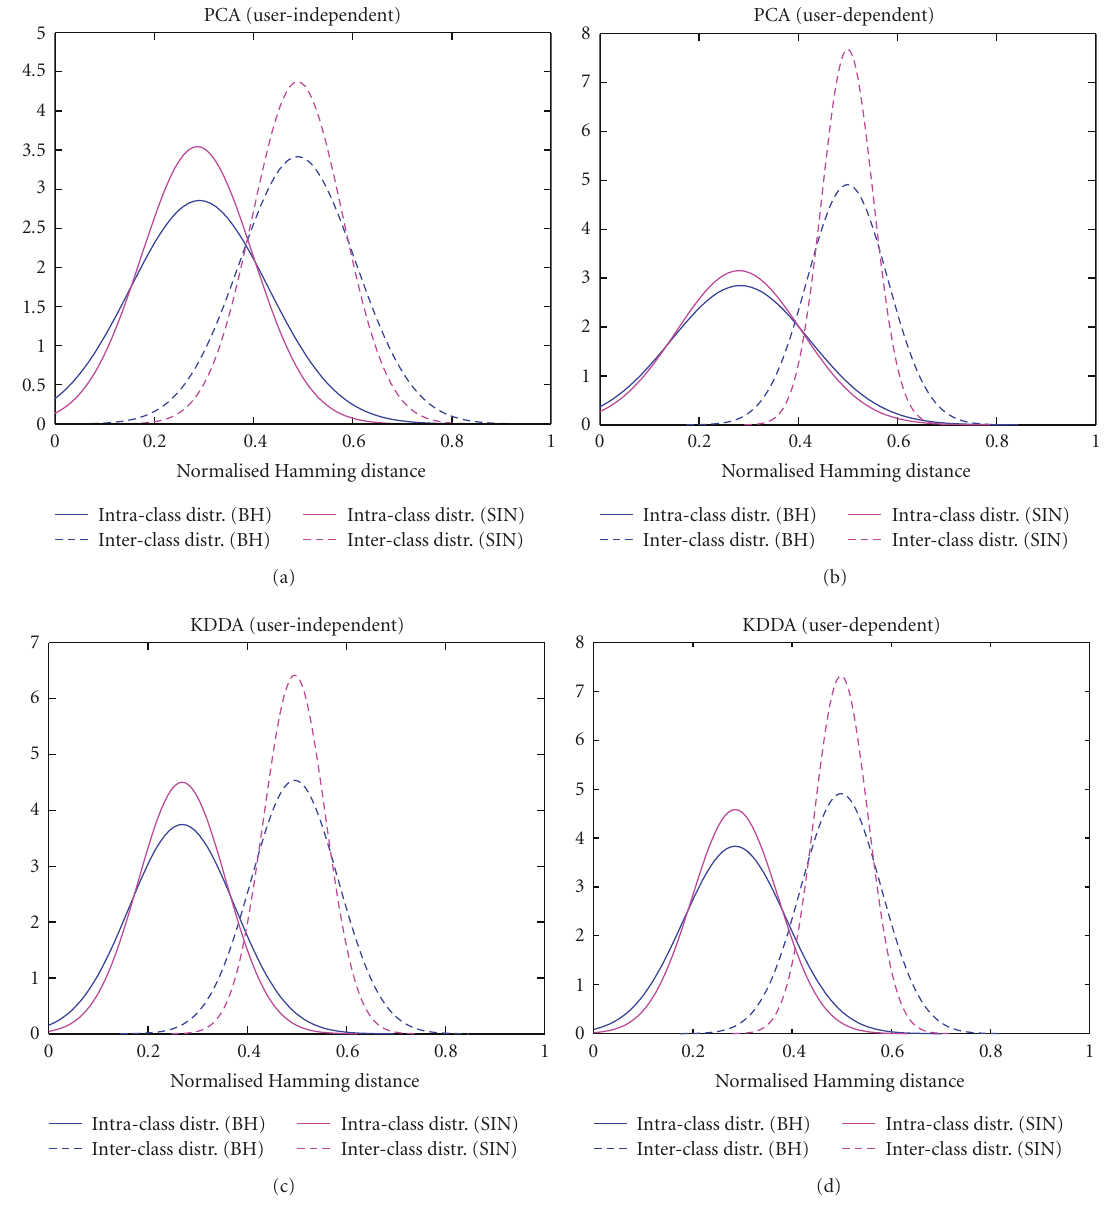
Figure 8: Intra-class and inter-class distributions of SIN and BH, using PCA and KDDA feature extractors, in both user-independent and user-dependent scenarios.